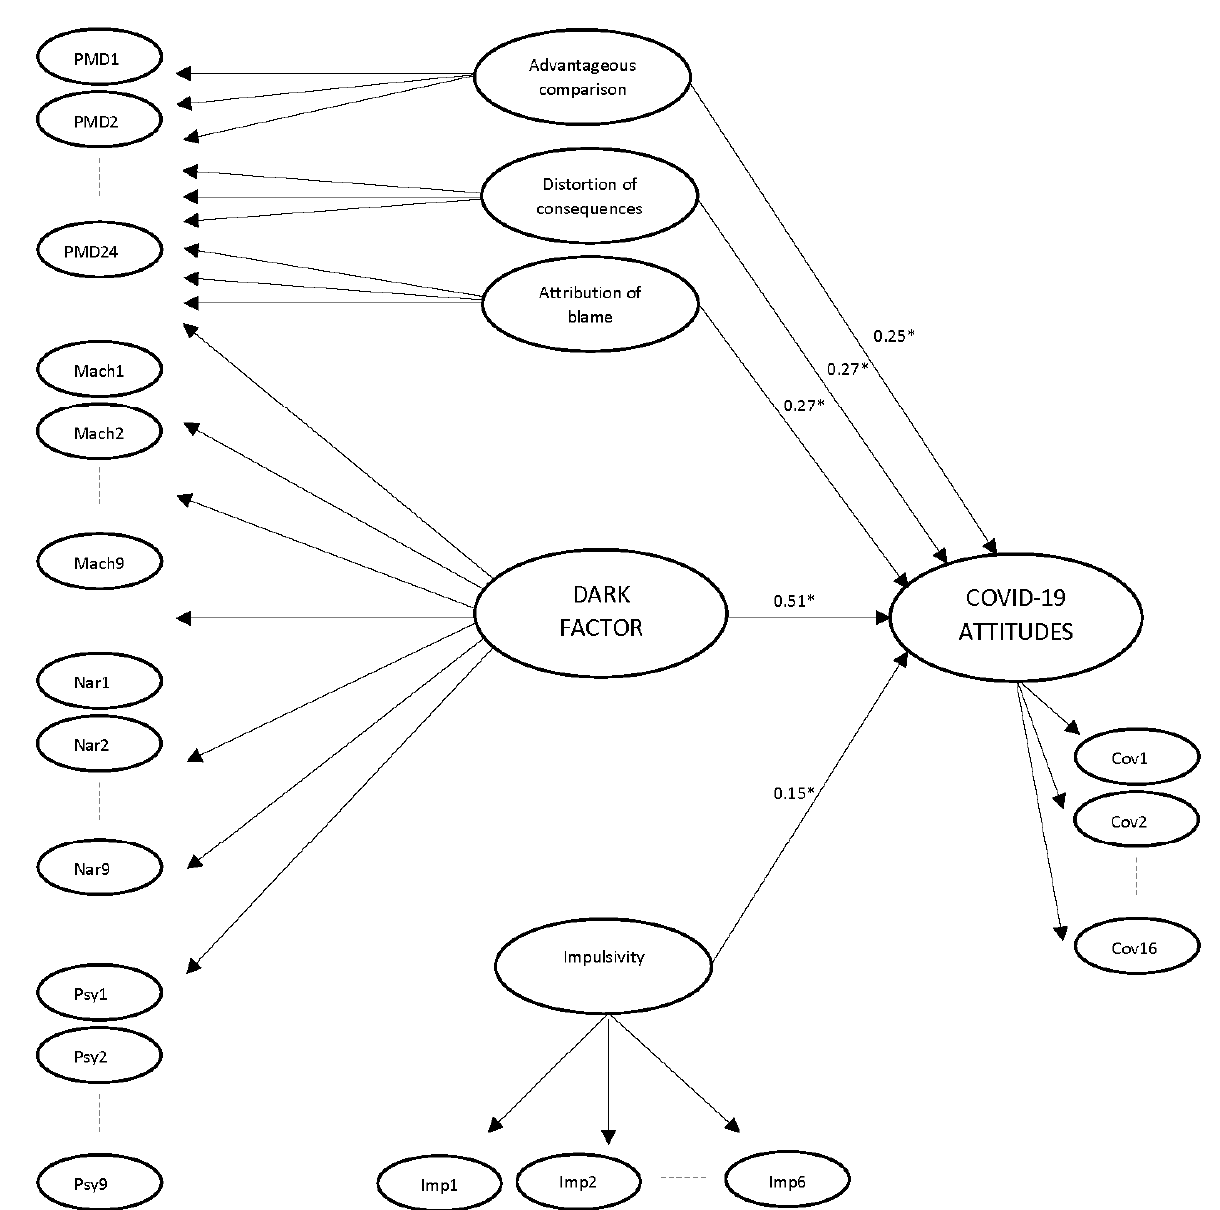
Figure 1. Bifactor model for predicting attitudes toward COVID-19. * p < 0.05. Standardized total effects.